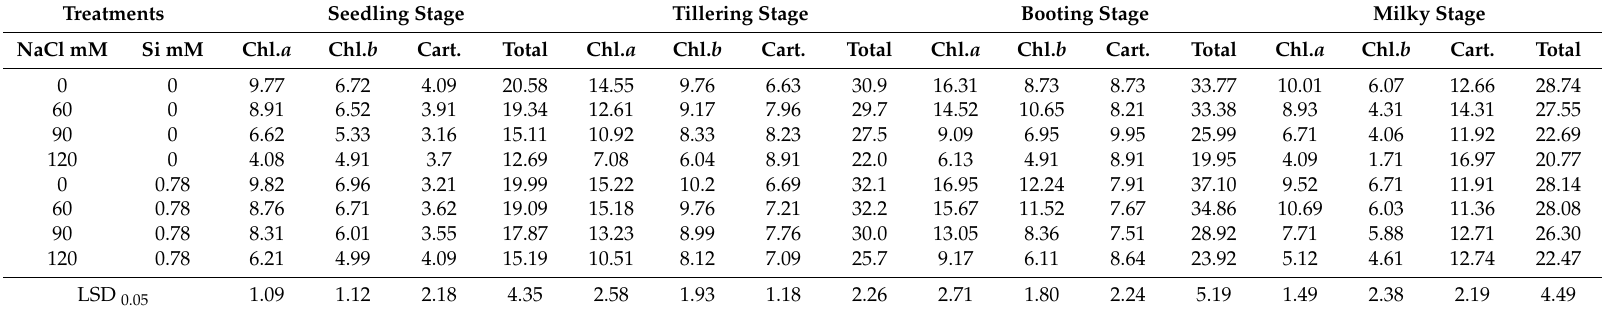
Table 2. Effect of NaCl on Chl. a and b and carotenoid contents (mg g − 1 fresh weight) of wheat leaves at different growth stages in the presence and absence of